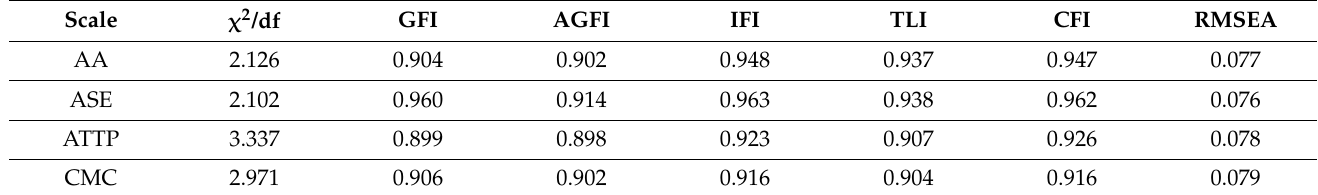
Table 6. Confirmatory factor analysis results of the